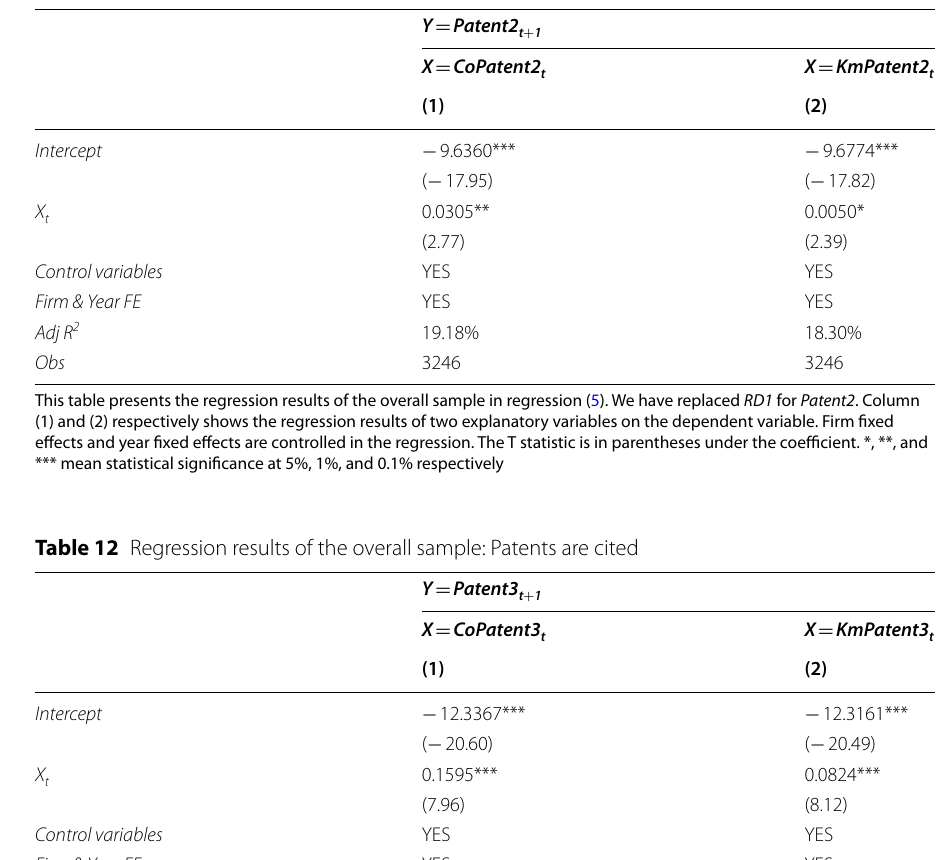
Table 11 Regression results of the overall sample: Authorized patent